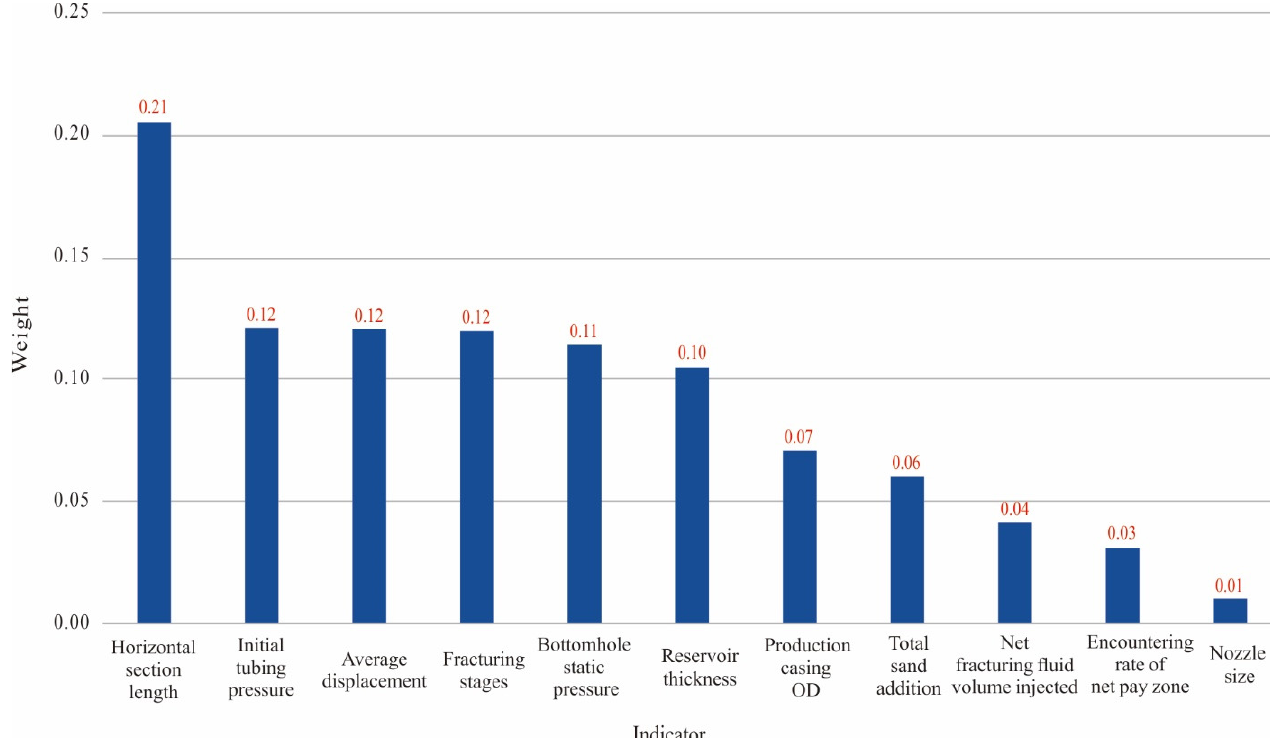
Figure 10. Weights of CPII indicators for fractured horizontal wells.